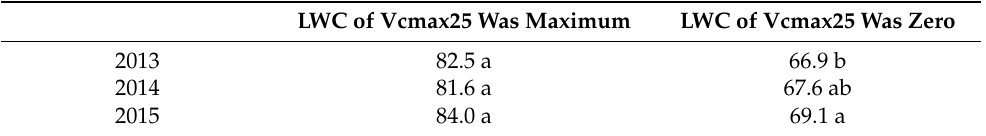
Table 4. The difference in LWC (%) when Vcmax25 reached threshold between experiment years.